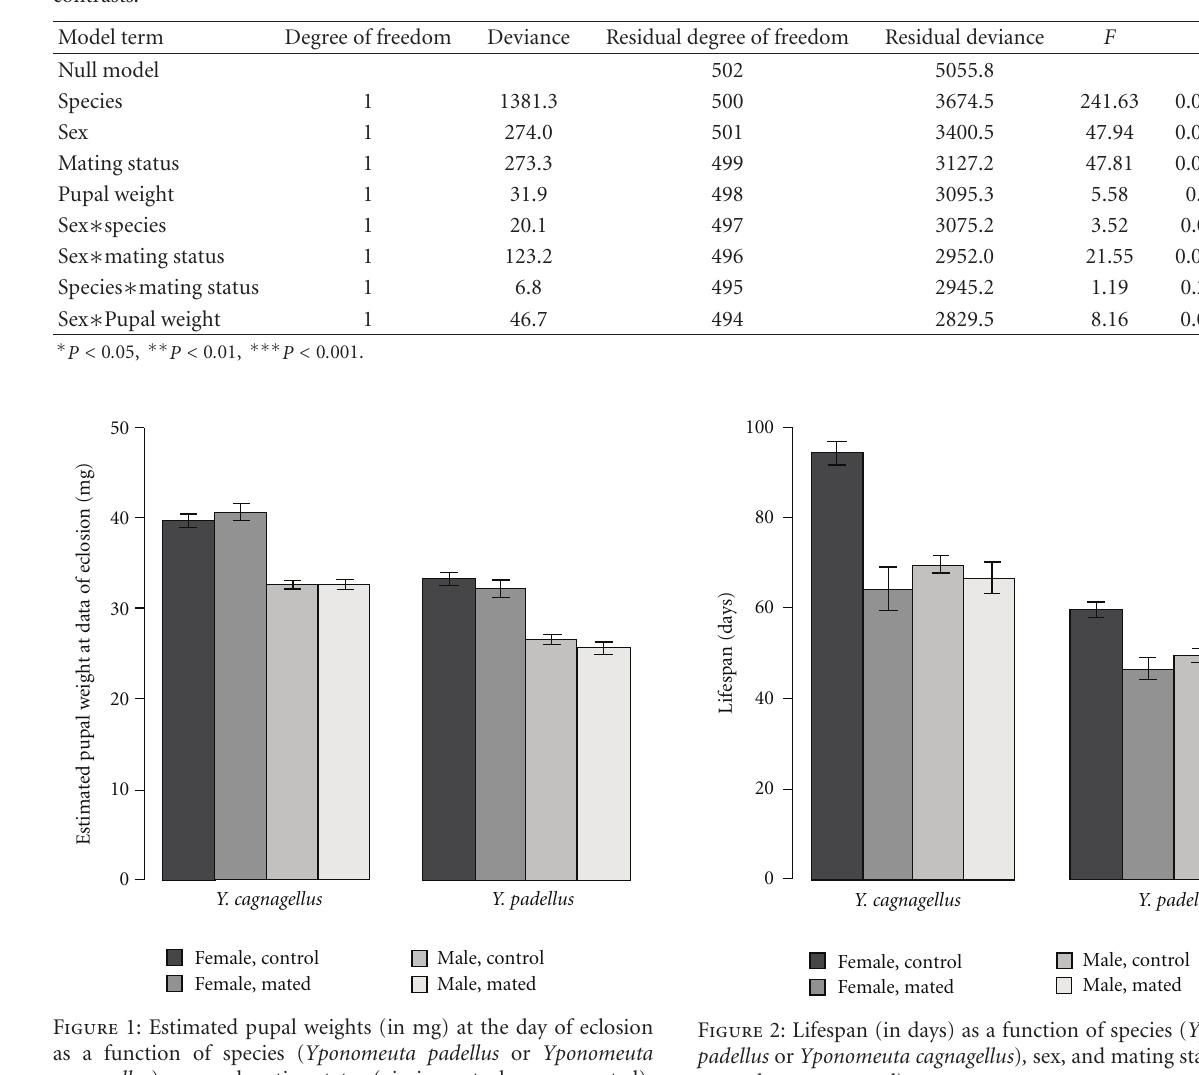
Table 2: ANOVA table of a GLM model to estimate the e ff ects of sex, species, mating status, the covariate pupal weight, and specific planned contrasts.